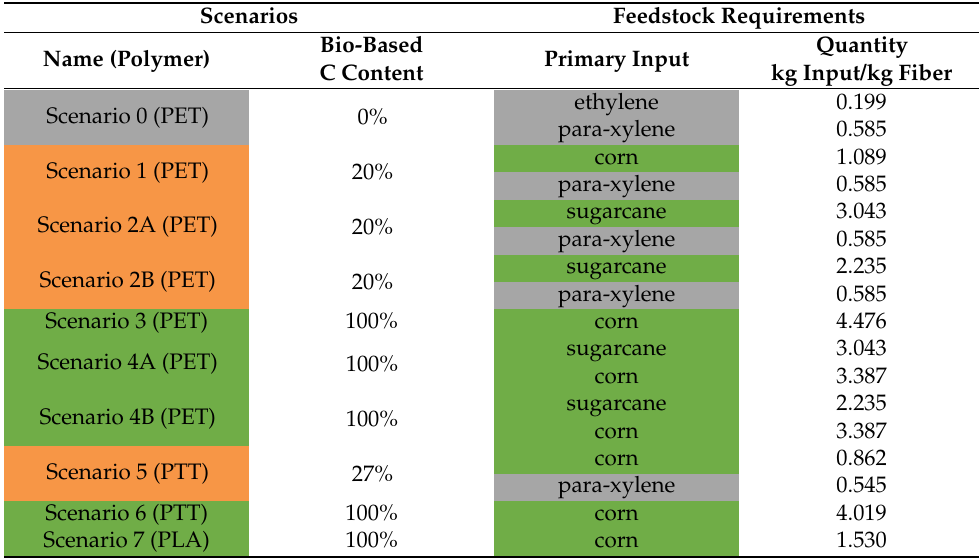
Table 1. Feedstock requirements for each scenario. Note that these results are independent of the impact assessment